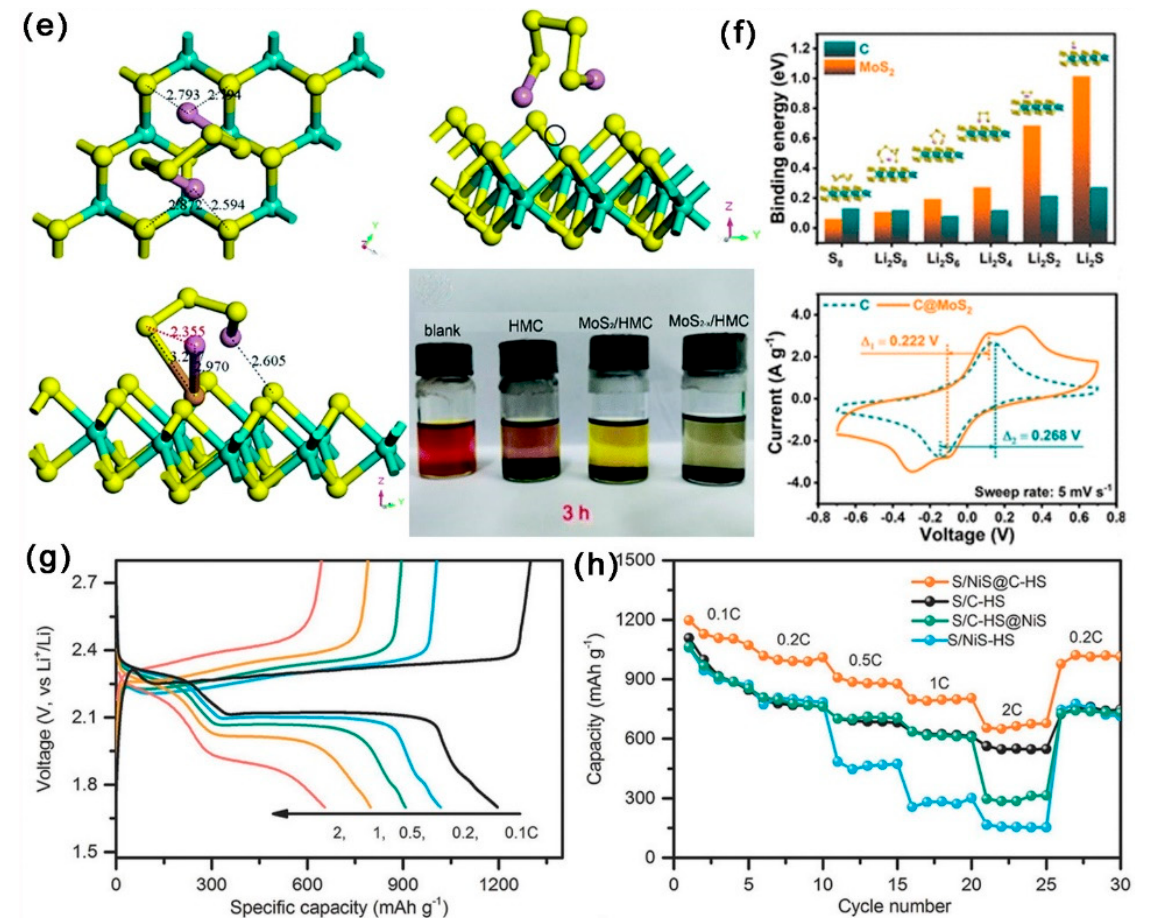
Figure 15. ( a ) Schematic diagram of the preparation of S@Co9S8-NSHPC, ( b ) SEM, ( c , d ) TEM images of Co 9 S 8 -NSHPC [106]. ( e ) Adsorption configurations of Li 2 S 4 on MoS 2 − X and visual adsorption experiments on a Li 2 S 6 electrolytes after adding MoS 2 − X /HMC (yellow: S, blue: Mo, purple: Li, black circle: Mo–S bond) [107]. ( f ) Binding energies for Li x S n species on MoS 2 and CV curves of C@MoS 2 electrode with 0.1 M Li 2 S 6 [108]. ( g ) Discharge/charge curves and rate capabilities of S/NiS@C-HS. ( h ) Rate capabilities of S/NiS@C-HS at 0.2 C. [109].